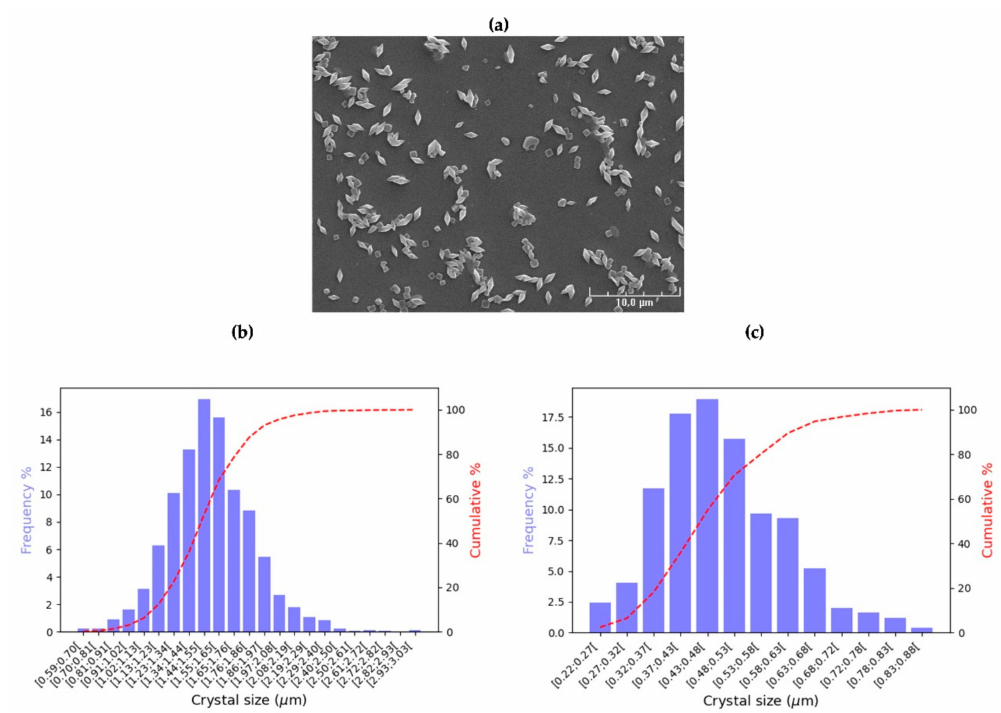
Figure 3. ( a ) SEM image of the LIP MKA purified crystals. ( b , c ) Graphs representing the size distribution in terms of frequency, along with the cumulative percentage of the bipyramidal height for the bipyramidal crystals and the cubic size of the cubic crystals.